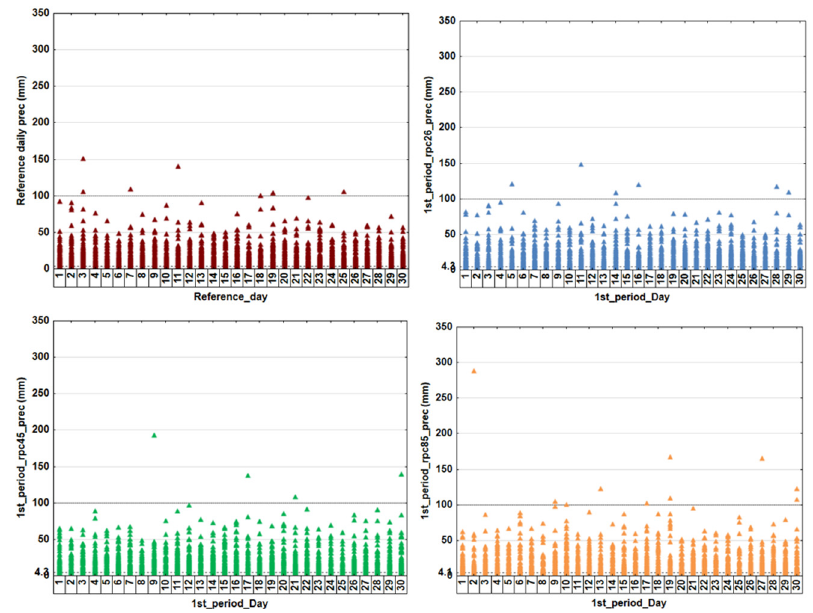
Figure 11. Fluctuations of daily precipitation values for the reference period and the climate scenarios of the first period. Dashed lines are reference lines for comparative purposes.